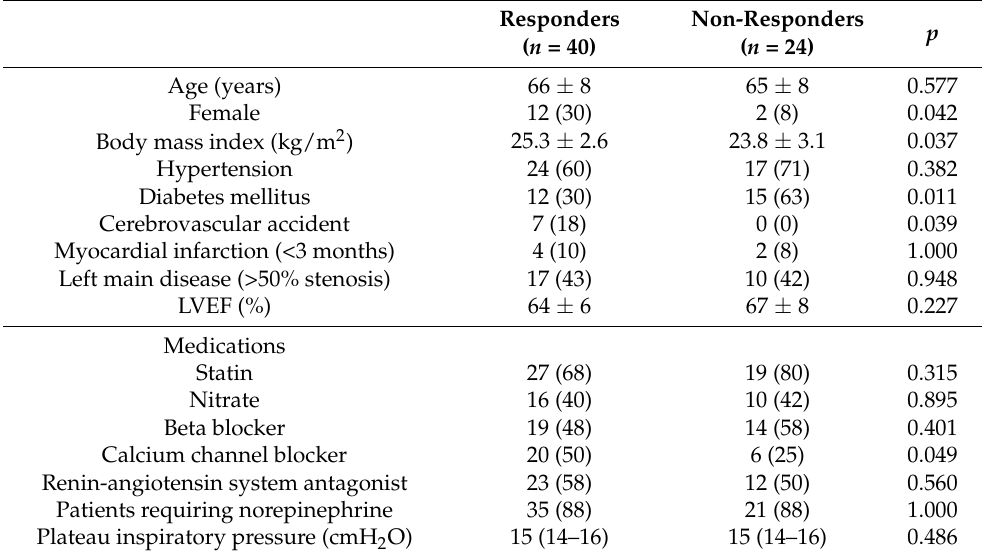
Table 1. Patients’ characteristics.